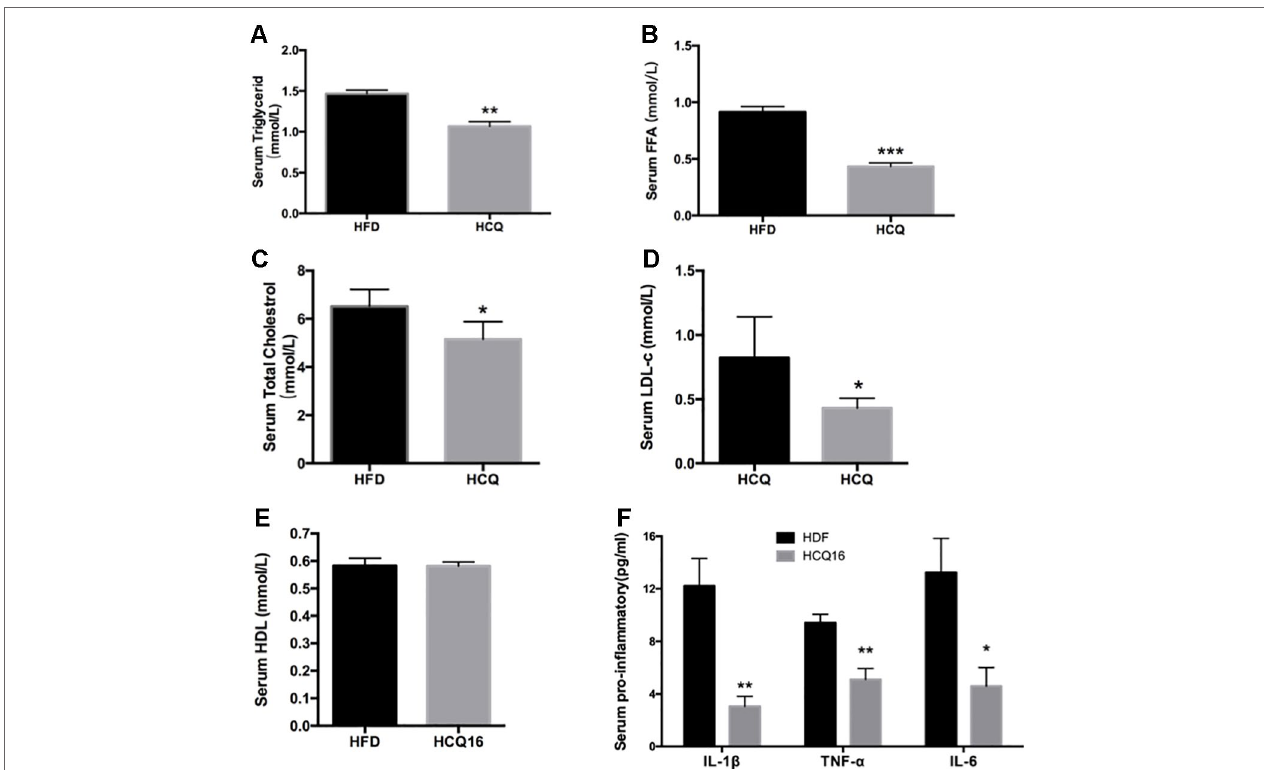
FIGURE 3 | HCQ reduces lipids in serum of high-fat induced mice. (A) (FFA), n = 11. (B) Triglyceride (TG), n = 8. (C) Total cholesterol (TC), n = 6. (D) Low-density lipoprotein cholesterol (LDL-c), n = 9. (E) High-density lipoprotein cholesterol (HDL-c), n = 11. (F) The pro-inflammatory cytokines IL-1 β , Ι L-6, and TNF- α , n = 5. After overnight fasting, the levels were measured in the serum of mice treated with vehicle or HCQ for 16 weeks. The values were presented as mean ± standard error of the mean (SEM). The error bars represent the SEM. Significant differences compared with vehicle controls were indicated by * P < 0.05 and ** P < 0.01 (assessed by Student’s t